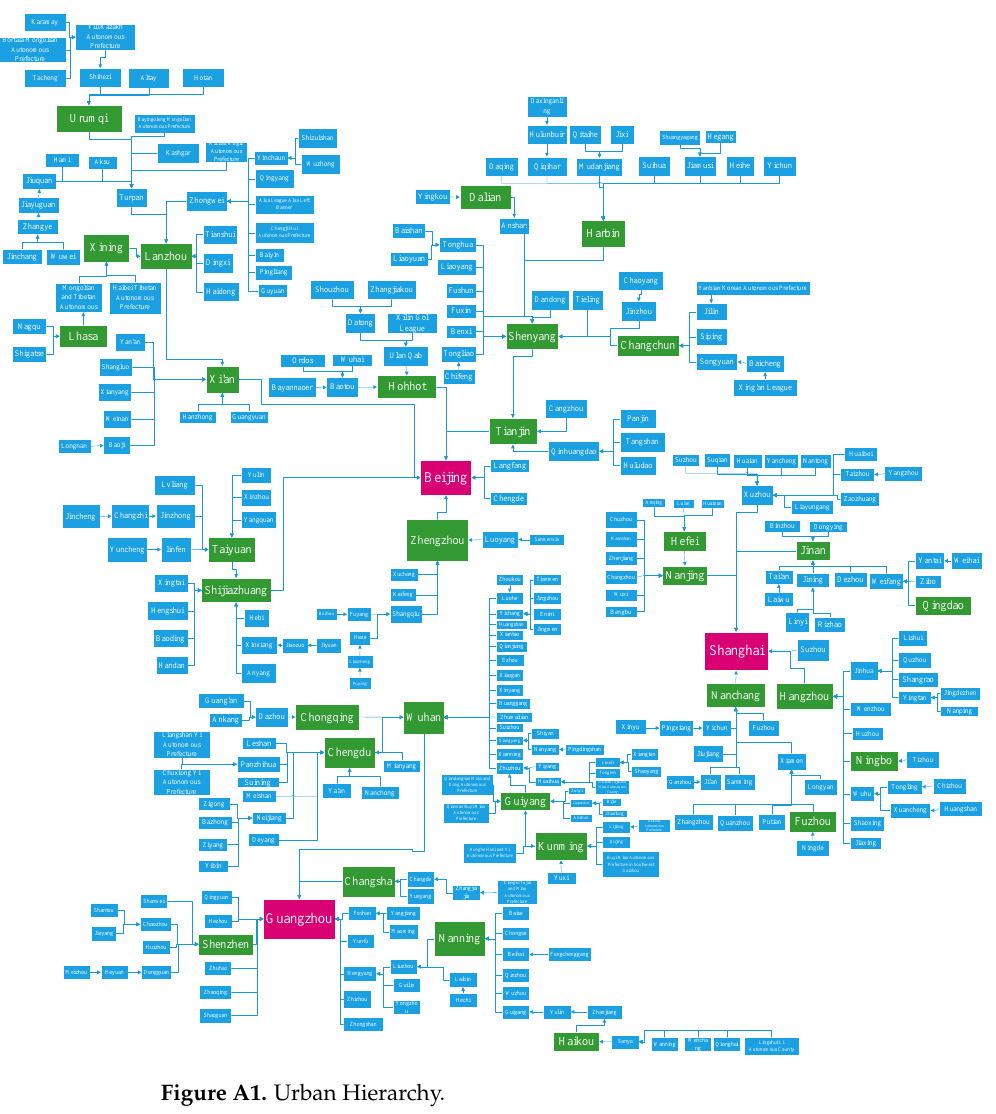
Figure A1. Urban Hierarchy.